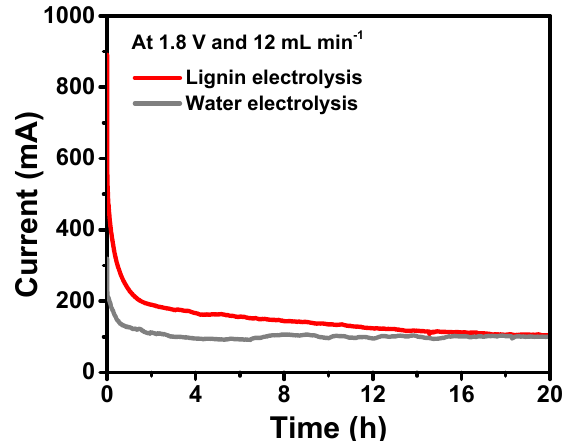
Figure 4. Chronoamperometry at a constant applied voltage of 1.8 V and 12 mL min − 1 electrolyte flow rate for water electrolysis and lignin electrolysis.